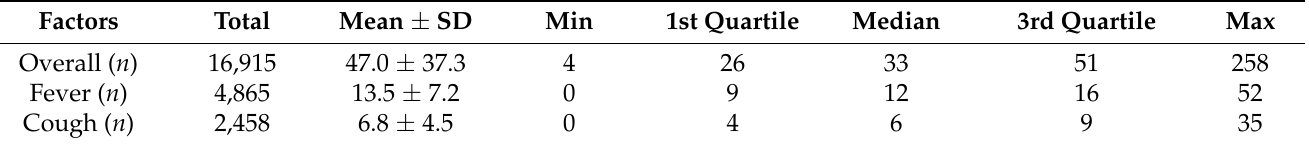
Table 3. Descriptive statistics for daily absence cases from school in overall, fever and cough.